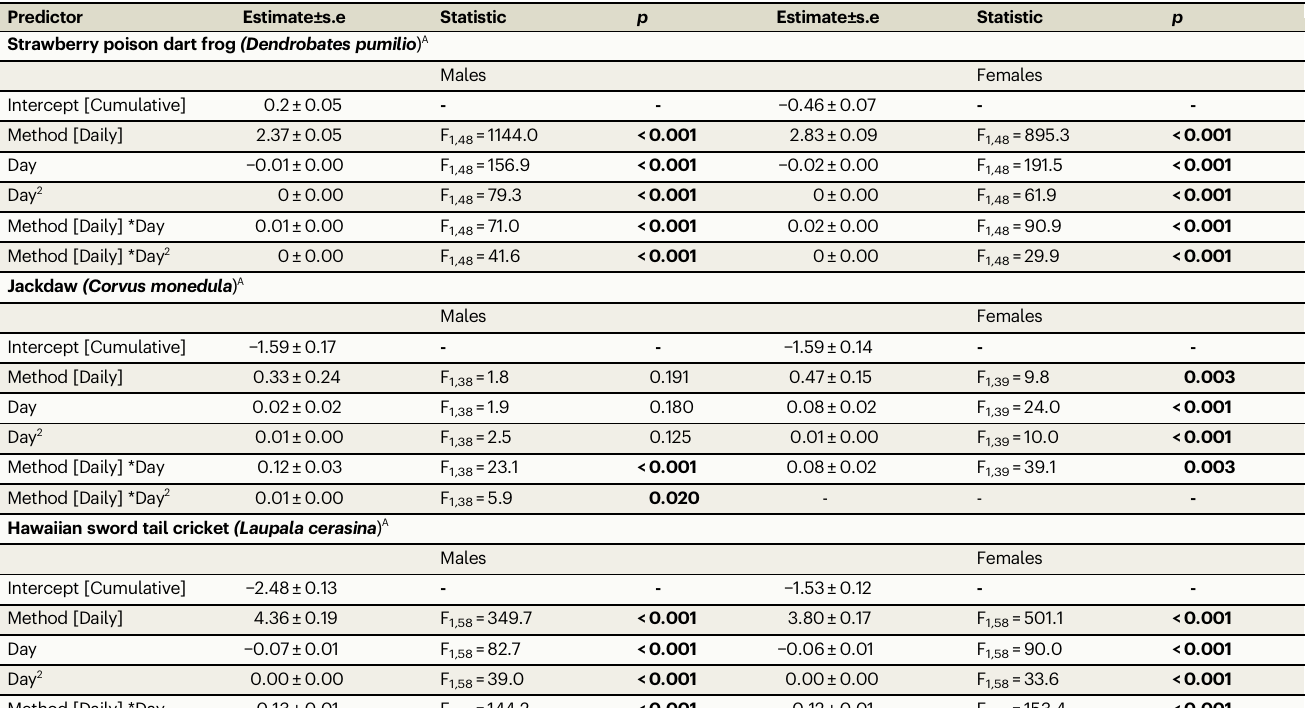
Table 1 | Temporal patterns in the opportunity for precopulatory sexual selection ( I M ) across successive days (Day) calculated using two different methods (i.e. cumulative or daily instantaneous mating success) for multiple animal species Predictor Estimate±s.e Statistic p Estimate±s.e